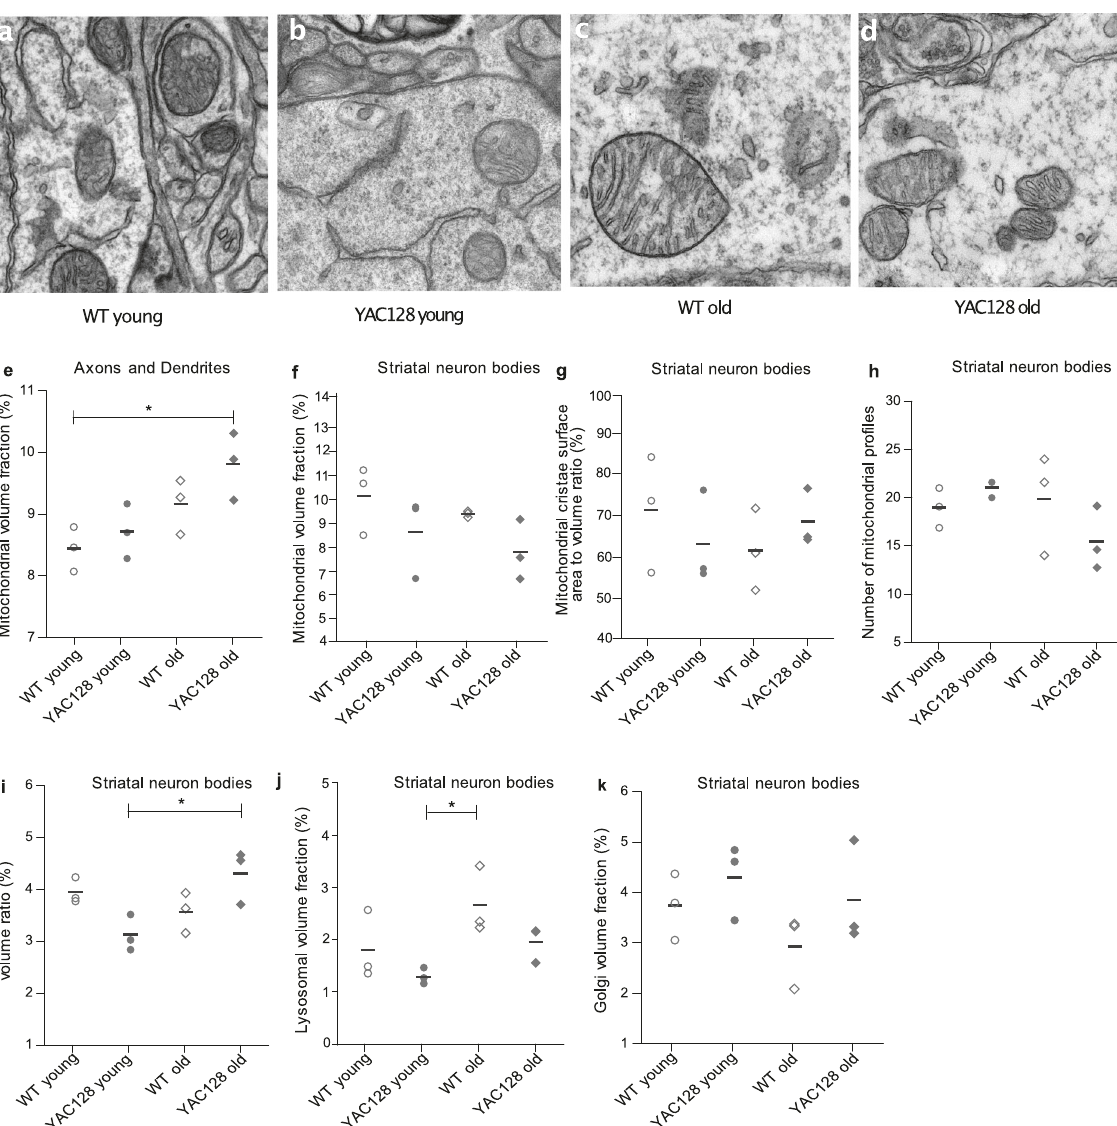
Fig. 1 Ultrastructural assessment of quality of mitochondria and mitochondrial mass. Striatal tissue was analyzed using transmission electron microscopy (TEM). Images randomly selected of striatal cell body with mitochondria, nuclear envelope and ER at ×46,000 magni fi cation from a young WT mouse, b young YAC128 mouse, c old WT mouse and d old YAC128 mouse. e Age had a signi fi cant effect on mitochondrial volume fraction (%) in the axon/dendrite regions adjacent to striatal neuron cell bodies. f Age and genotype had no effect on mitochondrial volume fractions of striatal neuron cell bodies, g mitochondrial cristae surface area to volume ratio of striatal neuron cell bodies, and h the number of mitochondrial pro fi les in striatal neuron cell bodies. i There was a signi fi cant age × genotype interaction effect on the nuclear surface area to volume ratio in striatal neuron cell bodies, which was increased in old YAC128 compared to young YAC128 mice. j Age had a signi fi cant effect on lysosomal volume fraction (%) in striatal neuron cell bodies. k Age and genotype had no effect on Golgi volume fractions in striatal neuron cell bodies. Dot plot shows dots where each dot represents the mean of 15 counted cell bodies or axon/ dendrites. n = 3 mice per group. The horizontal line indicates the mean. Two-way ANOVA with Tukey ’ s multiple comparison test was used for analysis. * p <